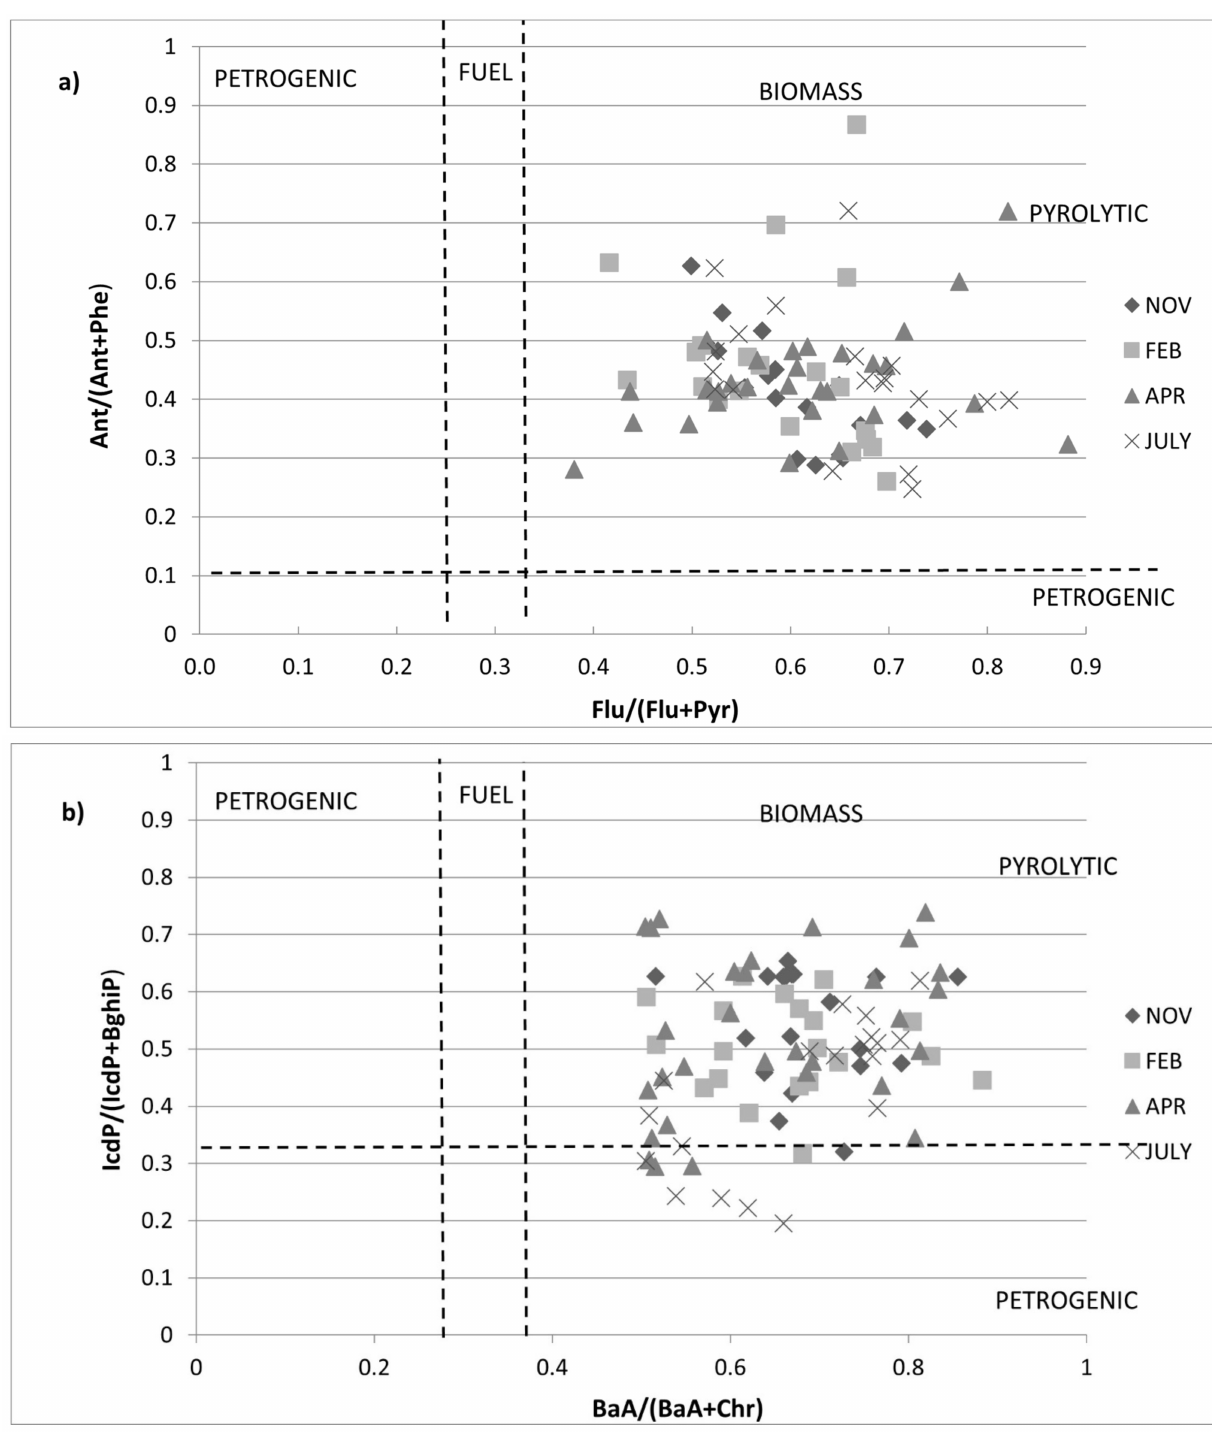
Figure 4. Cross plots of the values of ( a ) Flu/(Flu + Pyr) versus Ant/(Ant + Phe) and ( b ) BaA/(BaA + Chr) versus IcdP/(IcdP + BghiP) for all sample data from the Sele River and its